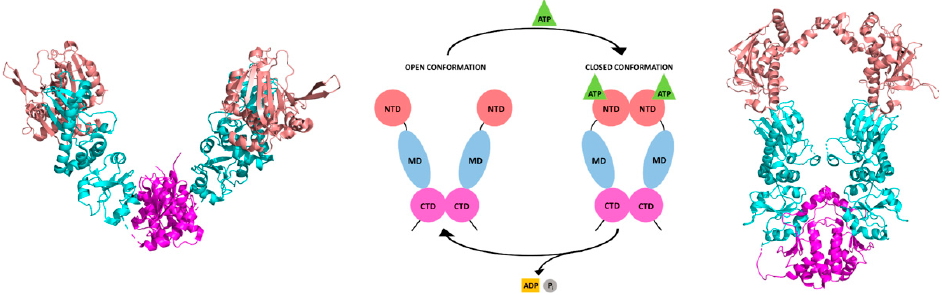
Figure 6. Schematic representation of the ATPase cycle of HSP90. The open and closed conformations are depicted. Since no structural information is available on full-length parasite HSP90, the rendering of the structures of the open and closed states of HSP90 has been done on a representative protein, Escherichia coli HSP90. To the left, the cartoon representations of the dimeric full-length Escherichia coli HSP90 in the open state (PDB id 2IOQ [80]) and in the closed state in complex with ADP (PDB id 2IOP [80]) to the right are shown. The NTD is colored coral, the MD cyan, and the CTD magenta.